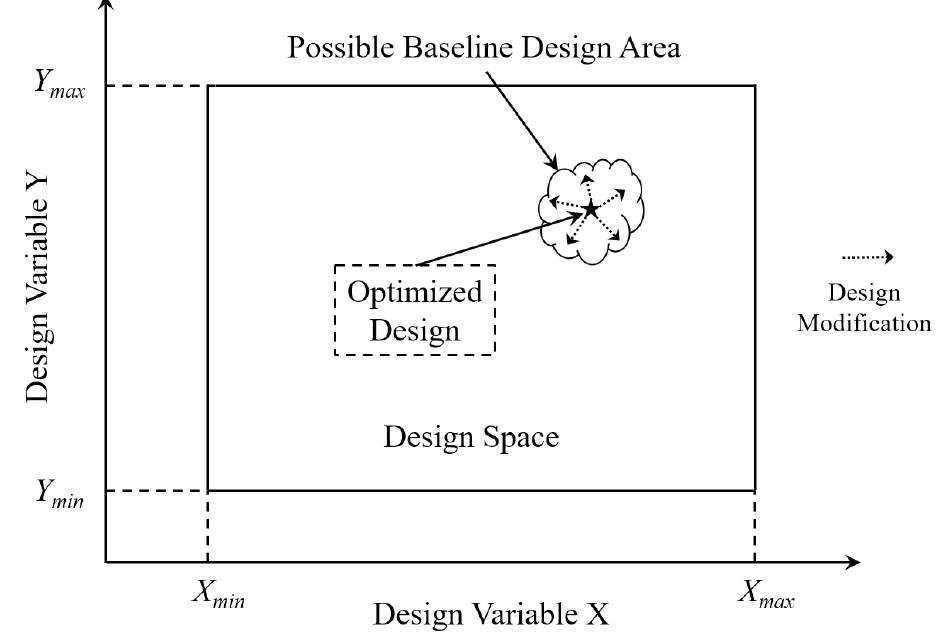
Figure 3. Optimization and design modification philosophy of the proposed process.